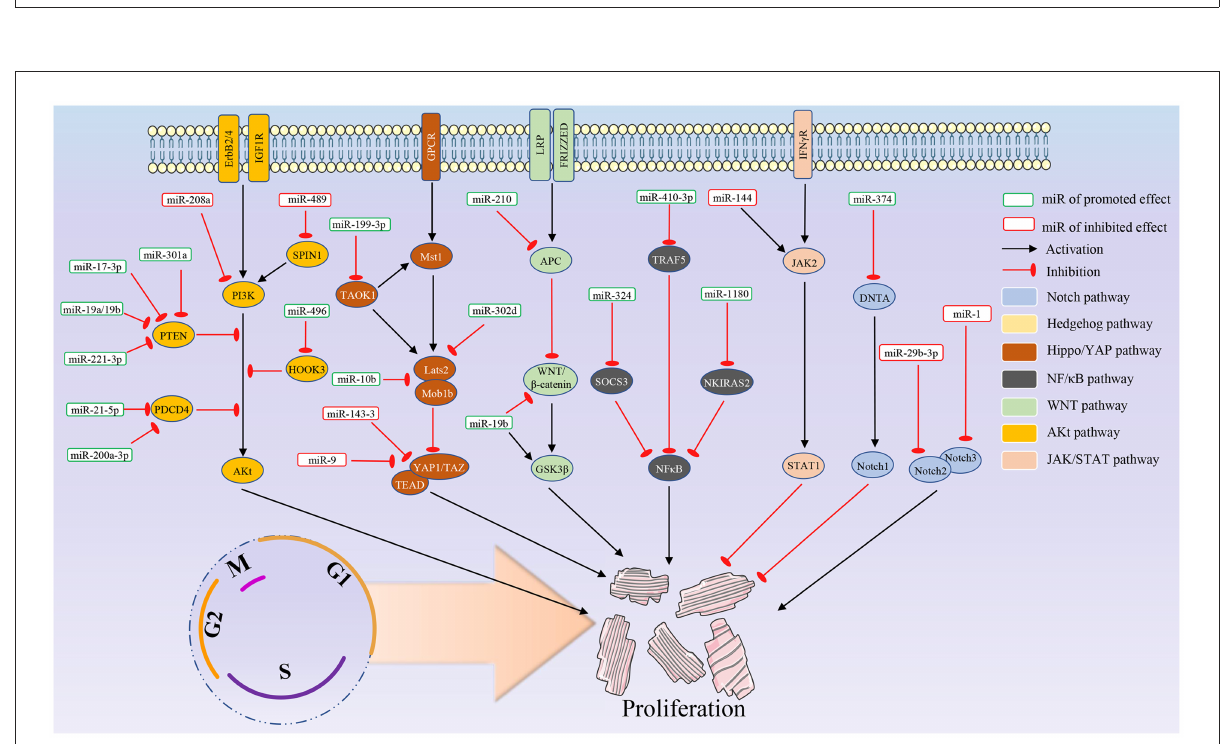
FIGURE2 The potential mechanism of the miRNAs on cardiomyocyte